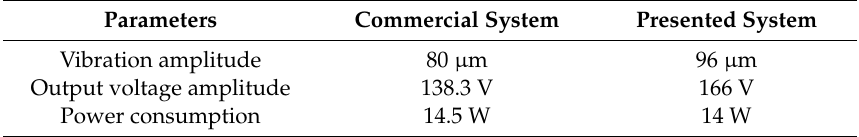
Table 3. Quantitative performance comparison between commercial and presented